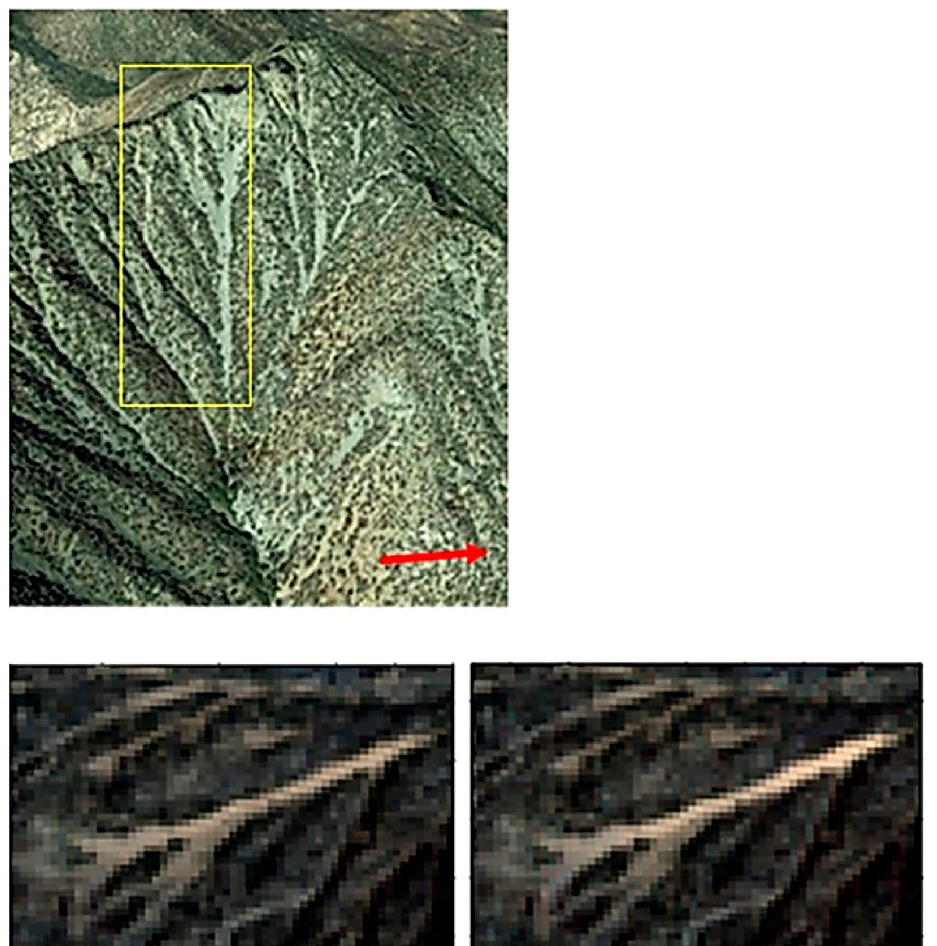
Figure 10. Rockfall failure on Sawtooth Peak. Top : Google Earth perspective view of the impacted debris chute looking from the east towards the summit of Sawtooth Peak. Red arrow points north. Lower left : 6/28/19 pre-earthquake. Lower right : 7/08/19 post-earthquake. The latter image shows a significant brightening in the middle and lower portion of the debris chute. North is up on both lower images and they are 750 m across.